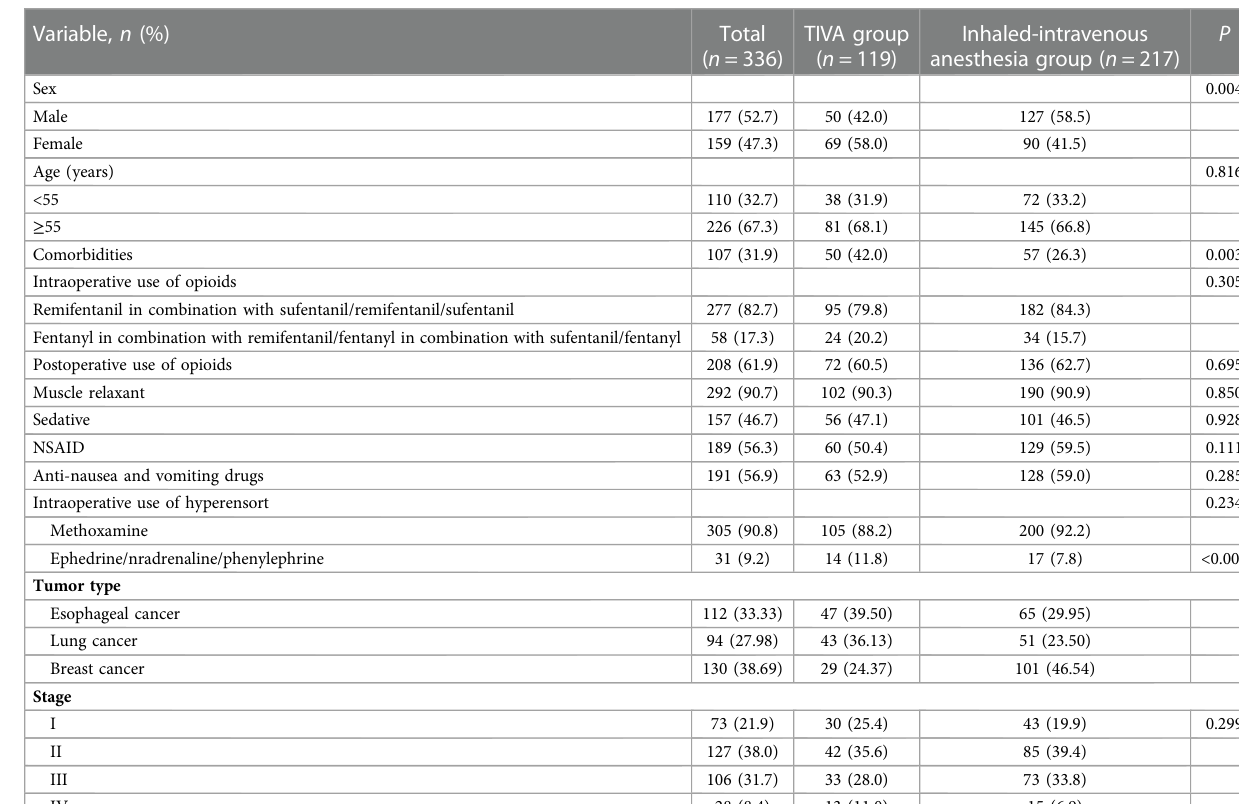
TABLE 1 Baseline characteristics of the